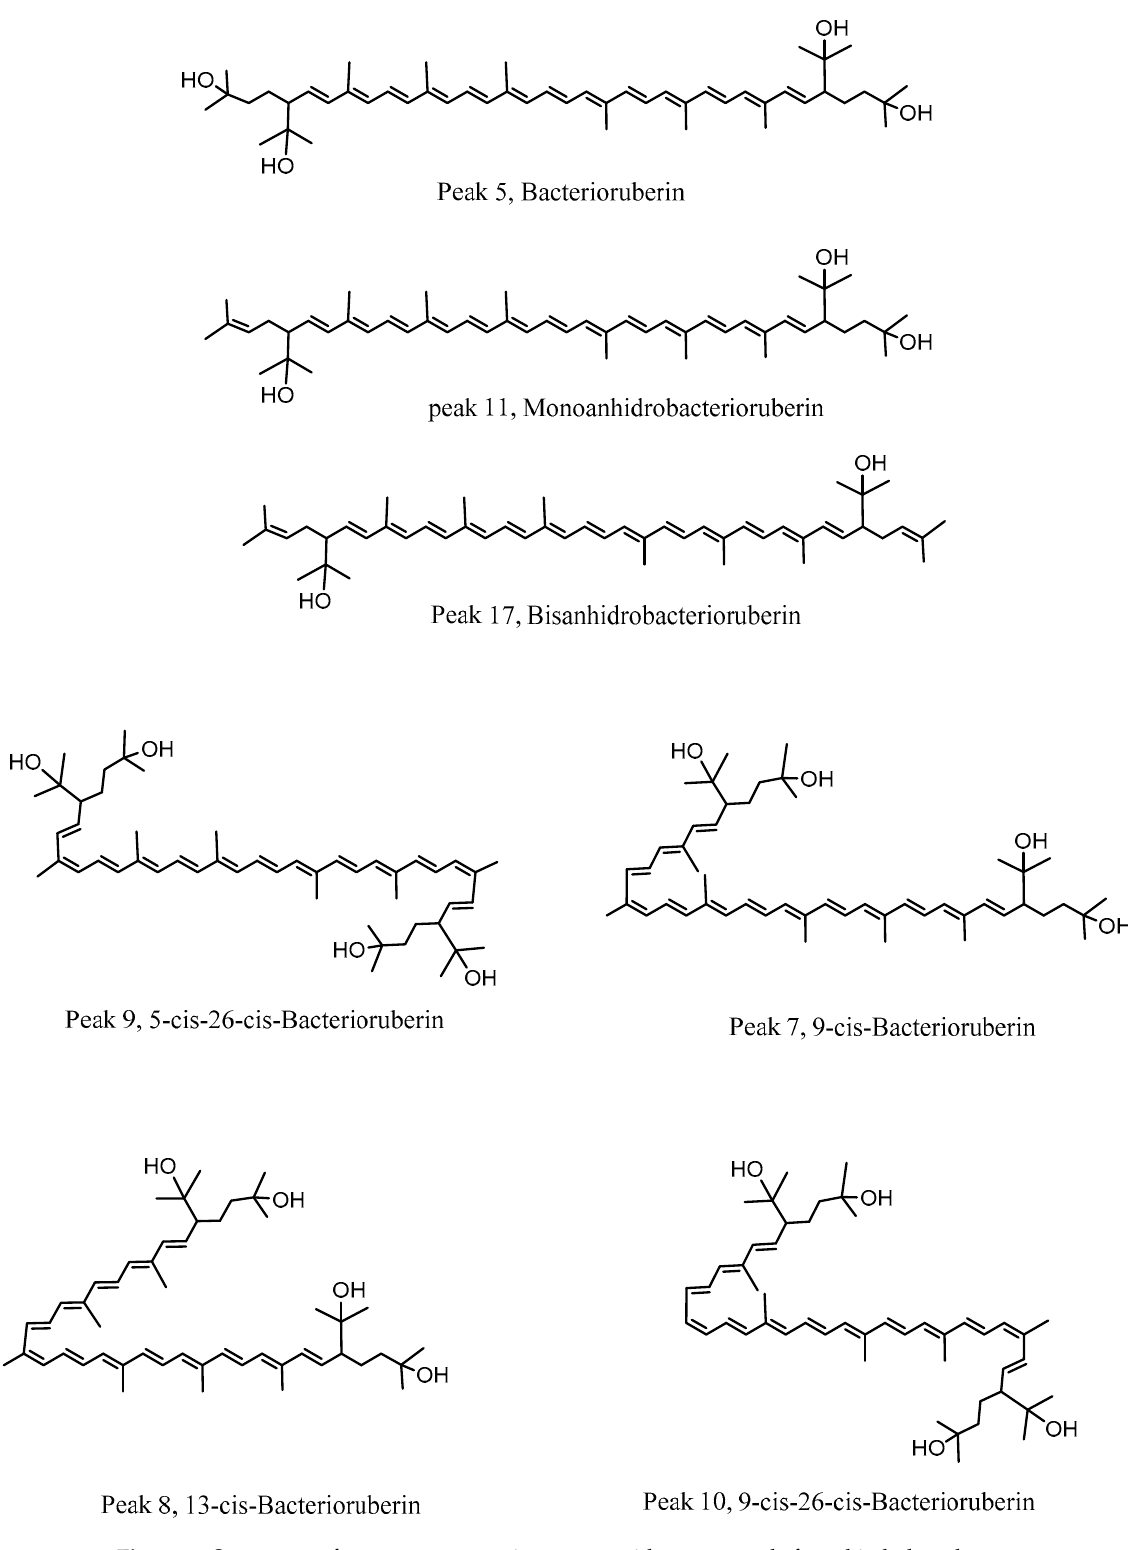
Figure 4. Structures of some representative carotenoids compounds found in haloarchaea.